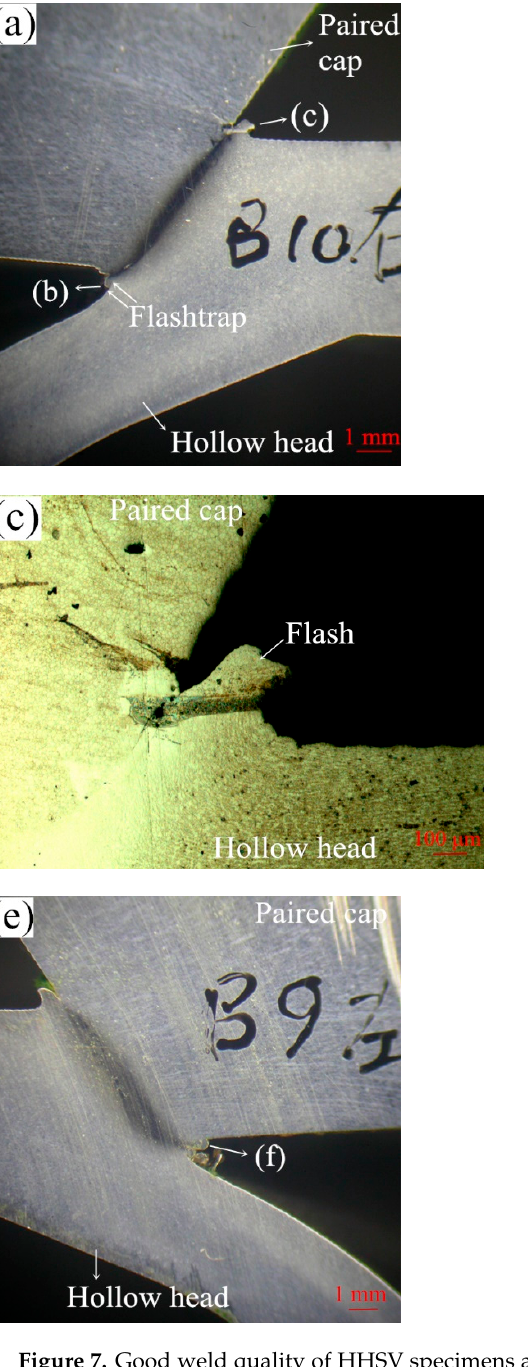
Figure 7. Good weld quality of HHSV specimens after friction welding process: ( a ) cross-section of “B10 right half” HHSV specimen; ( b ) inner edge of friction welding of “B10 right half” HHSV specimen; ( c ) outer edge of friction welding of “B10 right half” HHSV specimen; ( d ) inner edge of friction welding “B10 left half” HHSV specimen; ( e ) cross-section of “B9 left half” HHSV specimen; ( f ) inner edge of friction welding of “B9 left half” HHSV specimen.